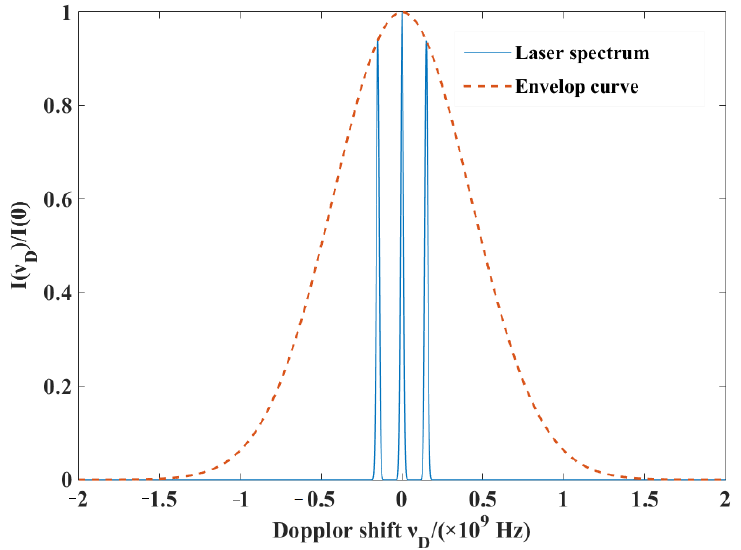
with three modes as in Figure 12.